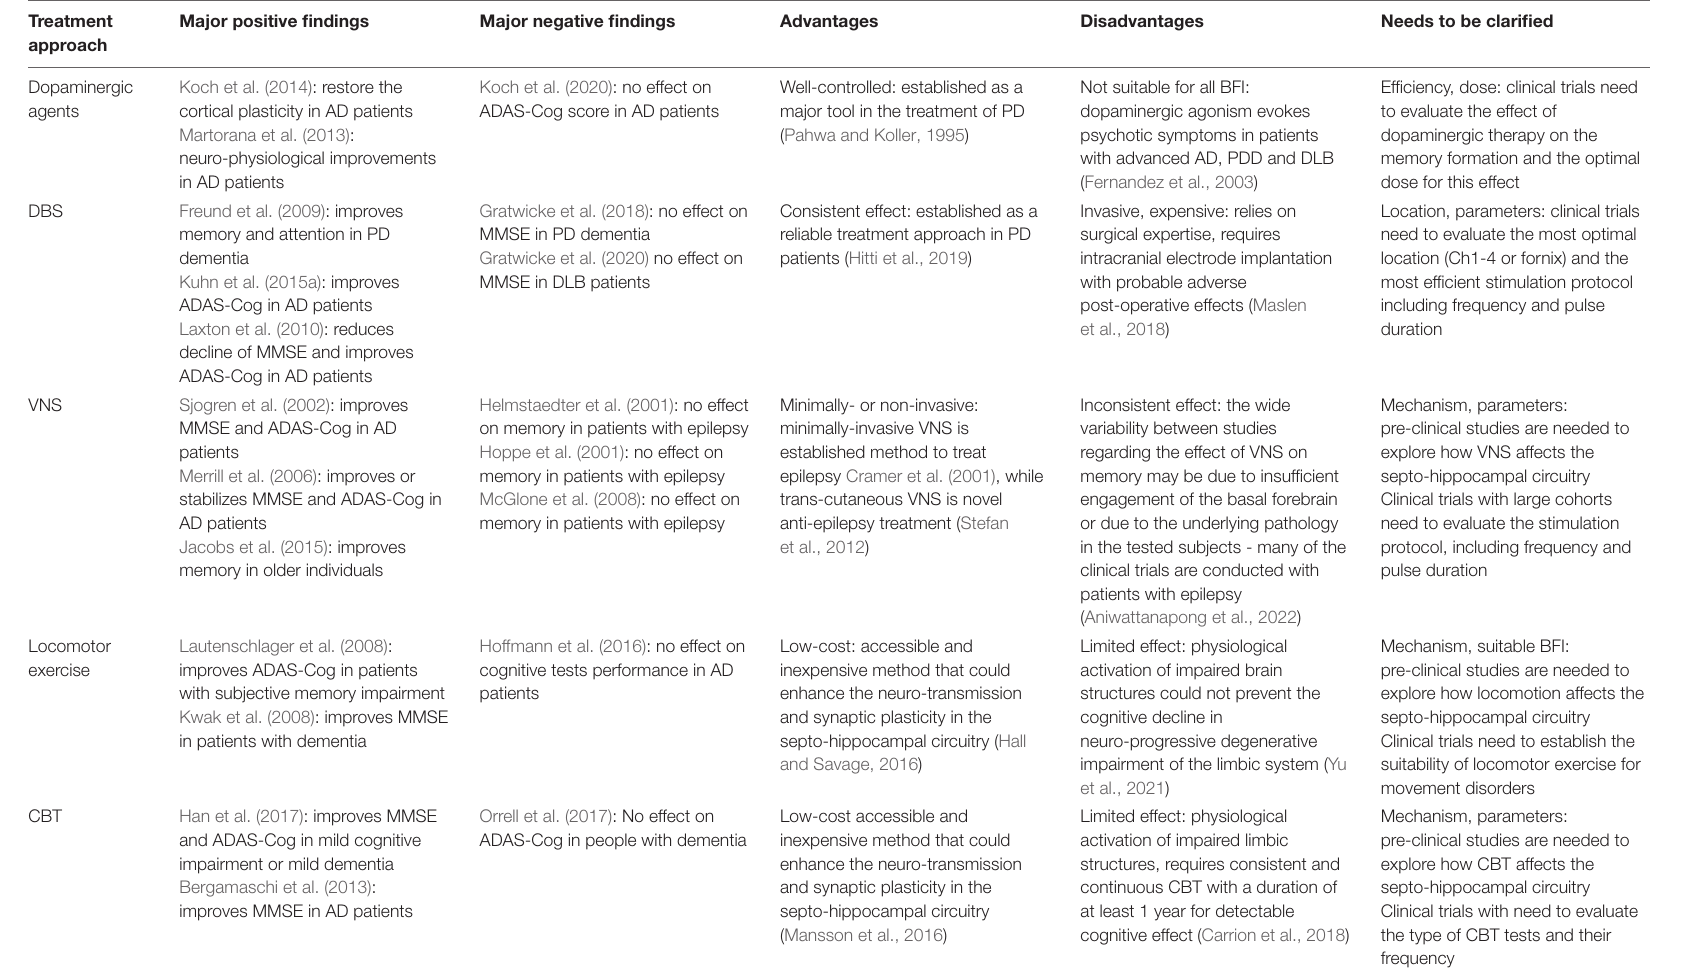
TABLE 1 | Summary of possible treatment strategies for basal forebrain